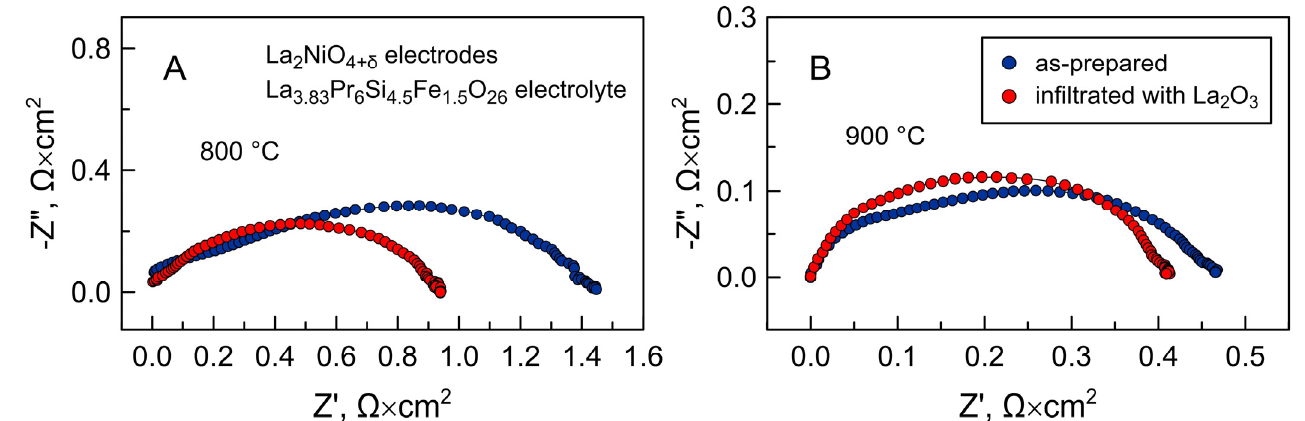
Figure 8. Electrochemical impedance spectra of La 2 NiO 4+ δ electrode, as prepared and infiltrated with lanthanum oxide, in contact with apatite ‐ type La 3.83 Pr 6 Si 4.5 Fe 1.5 O 26 solid electrolyte at 800 °C ( A ) and 900 °C ( B ). The spectra are corrected for ohmic contribution.